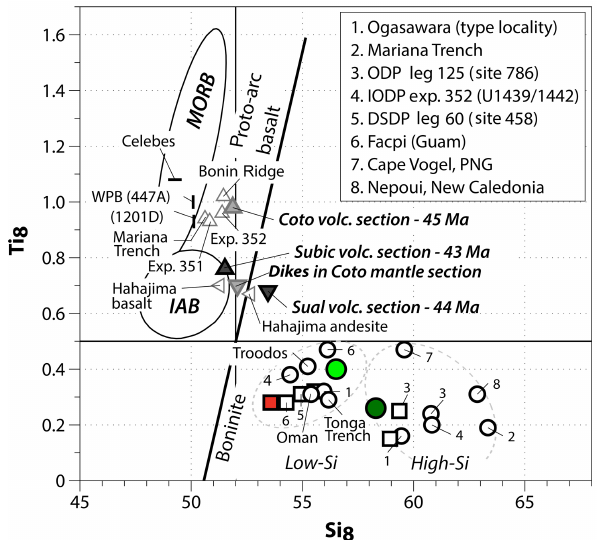
Figure 9. The 8wt% MgO-normalized SiO 2 (Si 8 ) and TiO 2 (Ti 8 ) values of the crustal sections of Zambales ophiolite and IBM fore- arc showing temporal evolution from proto-arc basalt, boninite to arc tholeiite associated with subduction initiation. Also shown are Si 8 -Ti 8 values of other notable boninite localities (Oman, Troodos, Tonga Trench). MORB and IAB fields are from Pearce and Robin- son (2010). Data sources are given in the text. Symbols are the same as in Fig. 6 except those shown in the